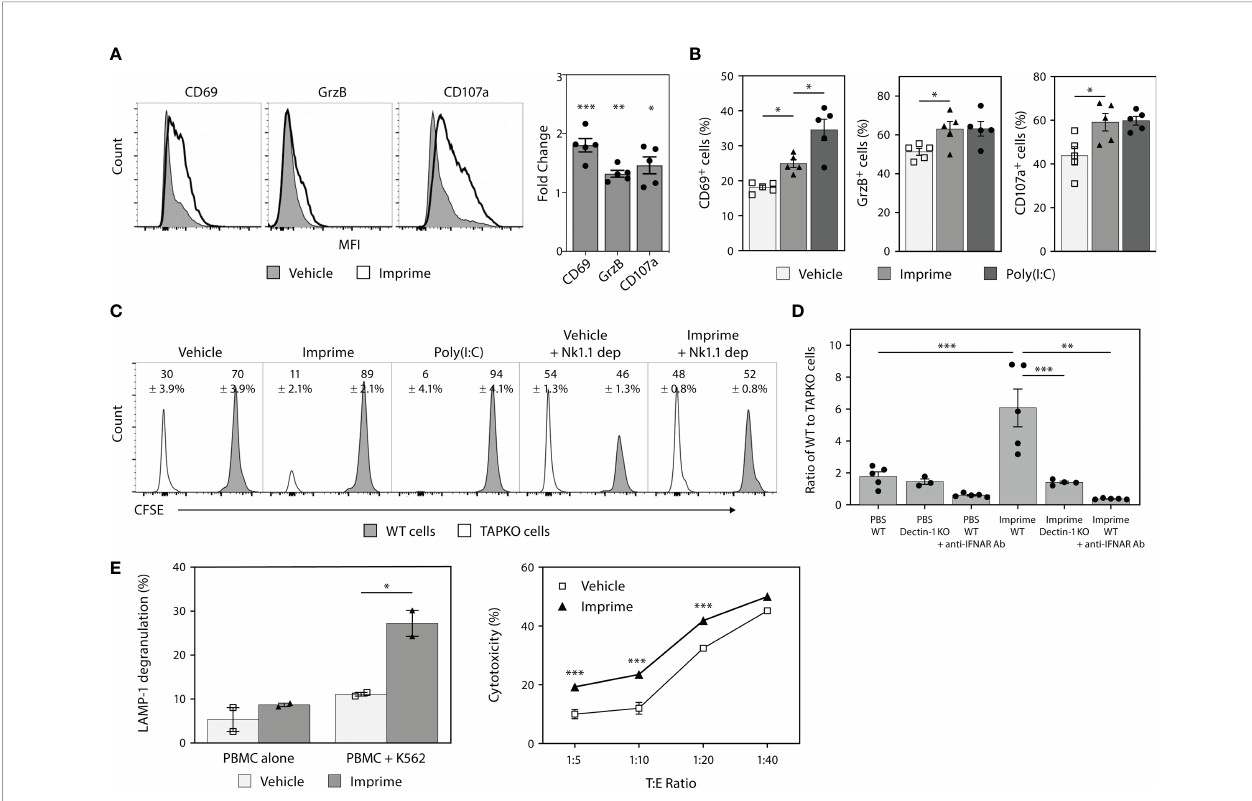
FIGURE 2 | Imprime treatment results in phenotypic and functional activation of mouse and human NK cells. Naïve C57BL/6 mice (n = 5) were injected i.v. with PBS, 1.2 mg Imprime, or 20 µg poly(I:C). (A) and (B) After 24 hours, expression of activation markers and percent activated cells on NK1.1 + CD3 - CD45 + splenocytes were analyzed by fl ow cytometry. (C) and (D) 24 hours post Imprime or poly(I:C) treatment, mice were injected i.v. with a 1:1 ratio of CFSE-labeled WT to CellTrace ™ violet-labeled TAPKO splenic cells, and recipient mice splenic cells were harvested 24 hours post injection. (C) Representative histogram and the average percentage change in WT and TAPKO cells with and without NK cell depletion and (D) the ratio of WT : TAPKO cells after pre-treatment with an anti-IFNAR Ab or in Dectin-1 KO mice are shown. (E) Cytotoxic function of NK cells was measured in human PBMCs using K562 cells as targets. PBMCs pre-treated with Imprime or vehicle for 3 days and then co-incubated with or without K562 cells for 4 hours. Cytotoxicity was measured by fl ow cytometry using CD107a surface staining (LAMP-1 degranulation) or Live/Dead staining on CD56 + NK cells. Representative results from ≥ 2 experiments are shown. All summary data are presented as mean ± SEM. Unpaired Student's t test was used in (A) One-way ANOVA with Tukey was used in (B, D) , multiple unpaired t -test was used in (E-left) , Two-way ANOVA with Holm-Sidak ’ s multiple comparison was used in (E-right) . * p < 0.05, ** p < 0.01, *** p <